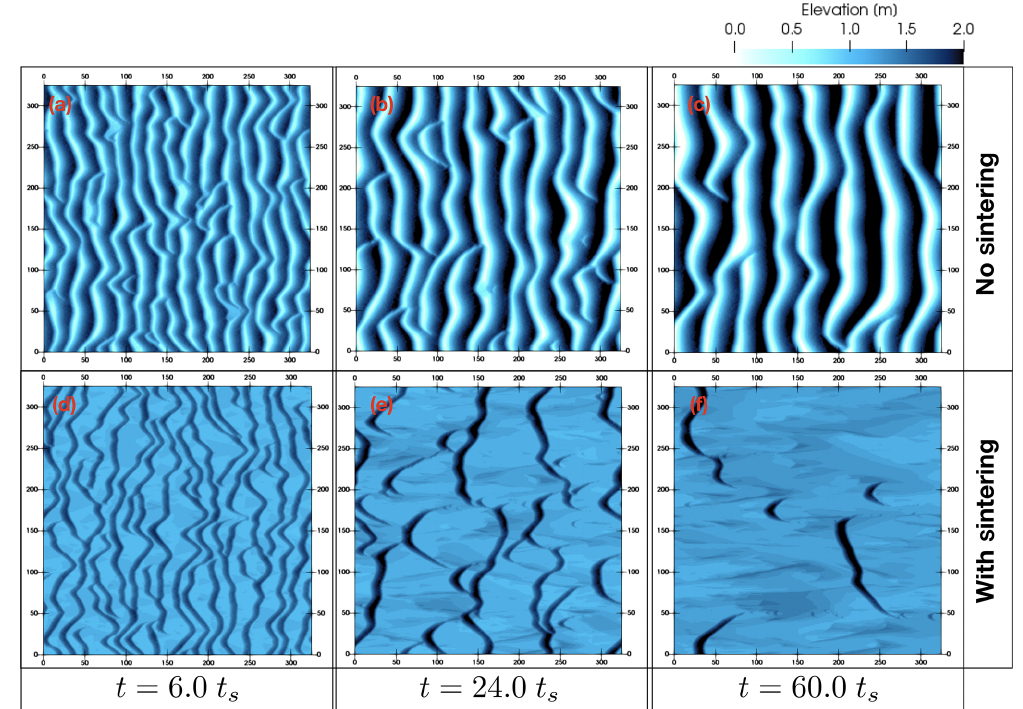
Figure 11. Evolution of an initially flat snow layer with a depth of 1.3m in the high-wind (UH) scenario.